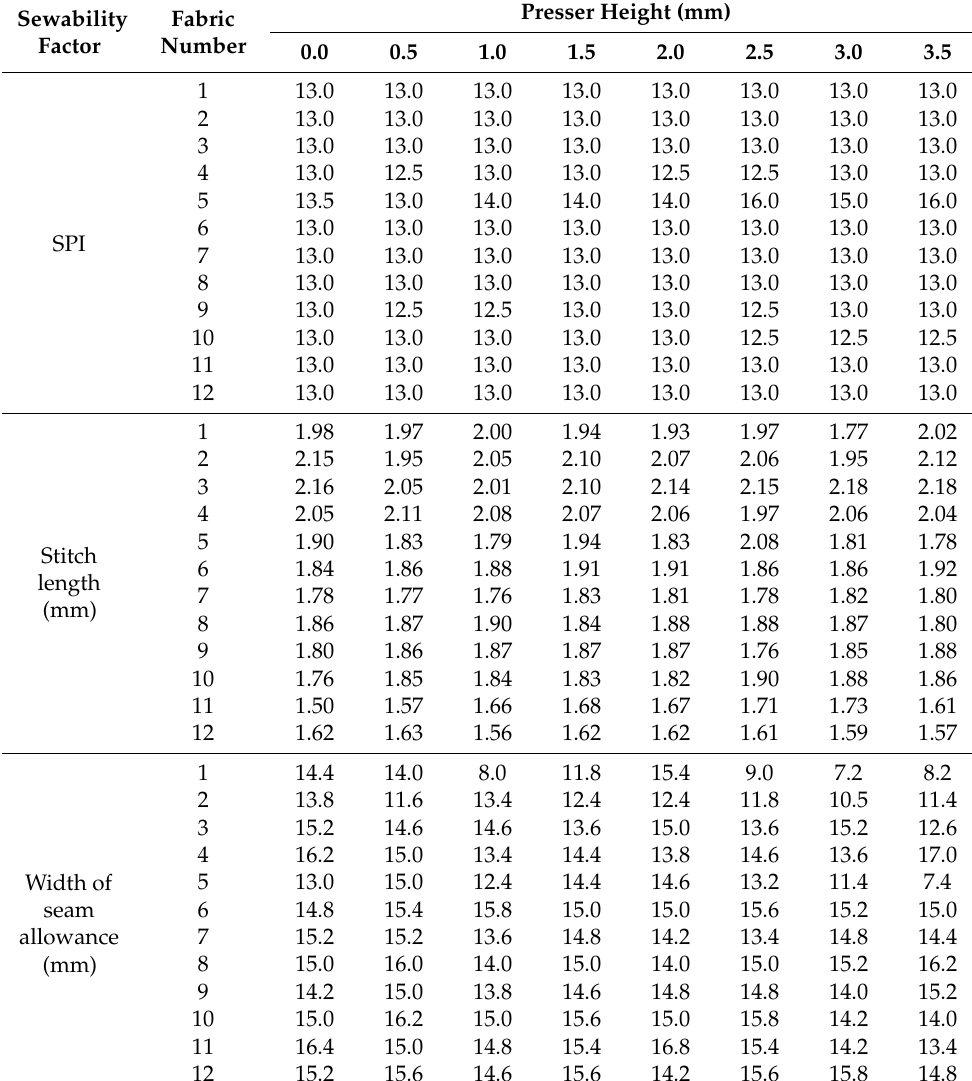
Table 3. Sewability of the lock stitch on each fabric according to the presser